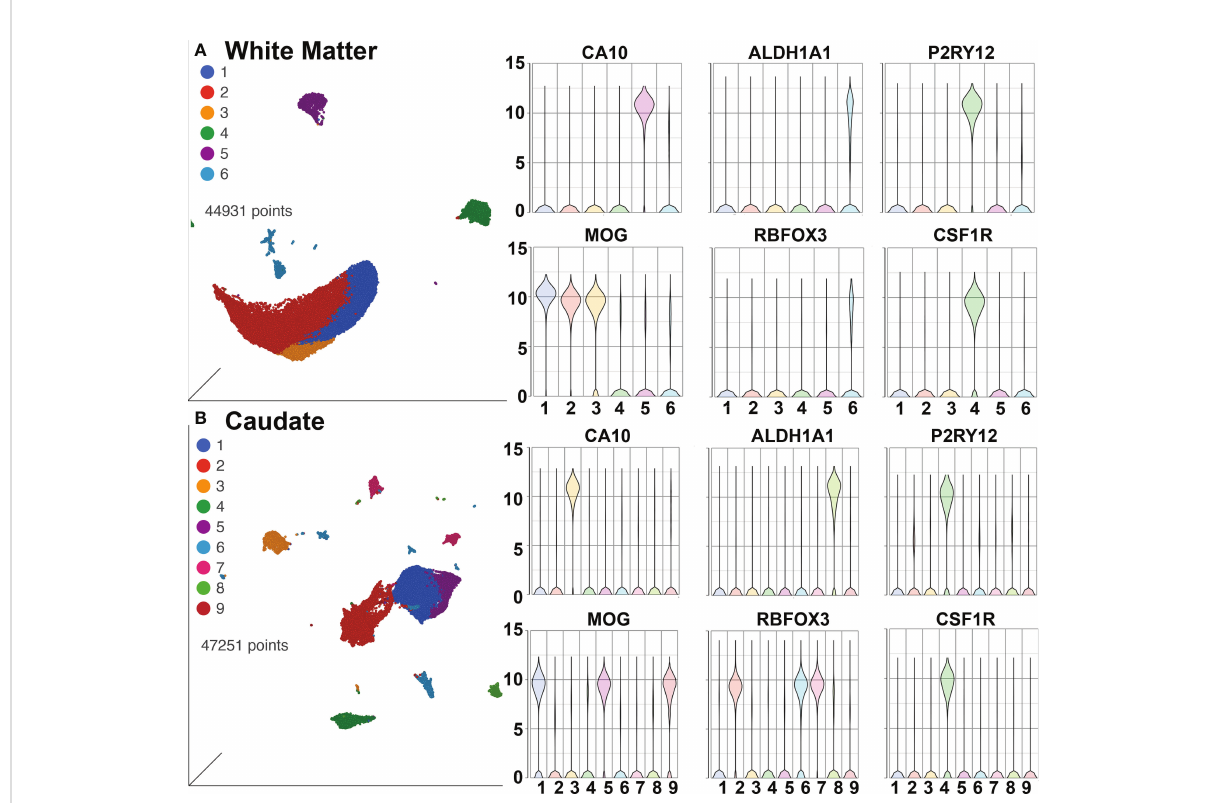
FIGURE 6 SnRNA-seq of brain regions. (A) White Matter and (B) Caudate. Left in each are UMAP plots, right are violin plots of cellular identifying markers. OPC express carbonic anhydrase 10 (CA10), oligodendrocytes myelin oligodendrocyte glycoprotein (MOG), astrocytes aldehyde dehydrogenase 1 family member A1 (ALDH1A1), neurons RNA binding Fox-1 homolog 3 (RBFOX3, also known as neuronal nuclei, NeuN), and microglia purinergic receptor P2Y12 (P2RY12) and colony-stimulating factor-1 receptor (CSF1R). Values on the Y-axis are the least-square mean expression (log 2 ).